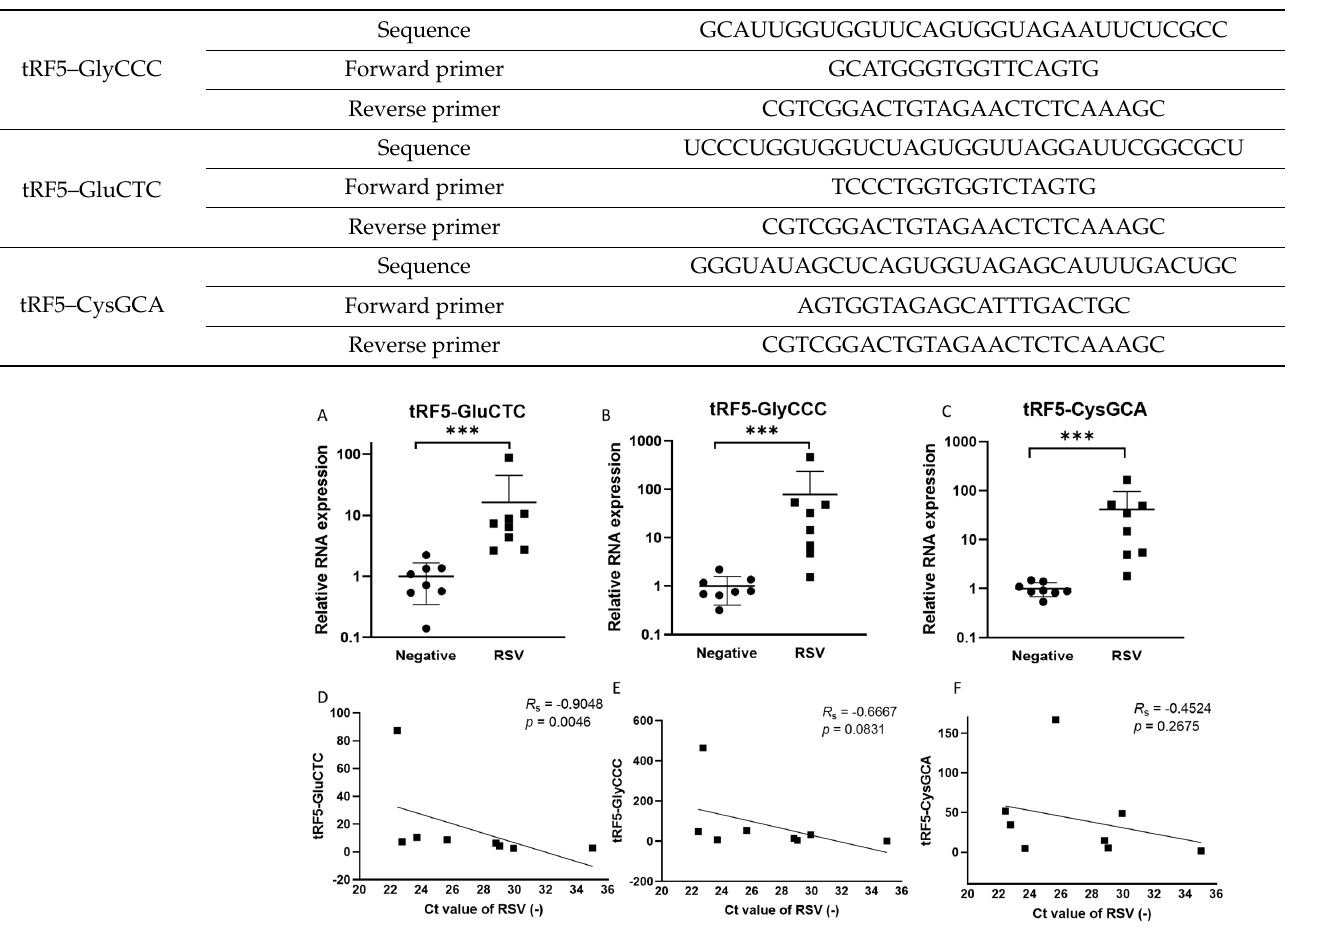
Figure 1. Changes in the expression of tRF5s in NPS samples by RSV. qRT-PCR was performed to detect ( A ) tRF5-GluCTC, ( B ) tRF5-GlyCCC, and ( C ) tRF5-CysGCA in the NPS from RSV and control (CN) patients. An unpaired two-tailed Mann-Whitney U test was used to compare two independent groups. The three asterisks represent a p -value of <0.001. For correlation analyses for tRF5-GluCTC ( D ), tRF5-GlyCCC ( E ), or tRF5-CysGCA ( F ) with NPS viral genome copies, we performed Spearman’s rank correlation test. Spearman’s rank correlation coefficient (R S ) was used to determine correlations. A p -value of less than 0.05 was considered significant.